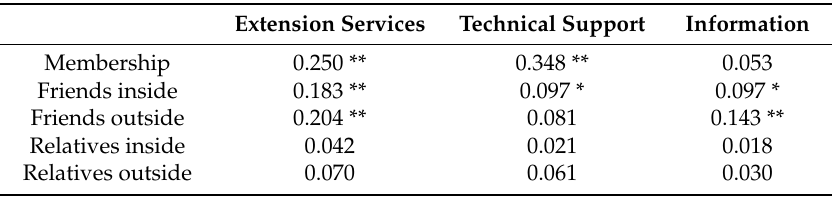
Table A4. Spearman’s Rank